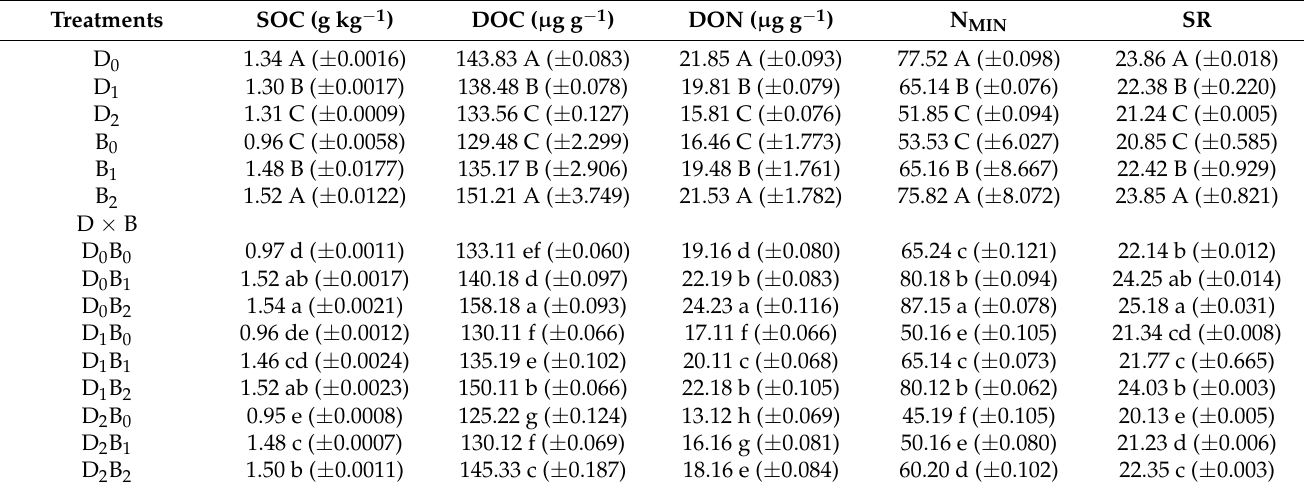
Table 5. Effect of Biochar on SOC (Soil organic C), DOC (Dissolved organic C), DON (Dissolved organic N), N MIN (Nitrogen Mineralization), and SR (Soil Respiration) under water-limited stress condition.